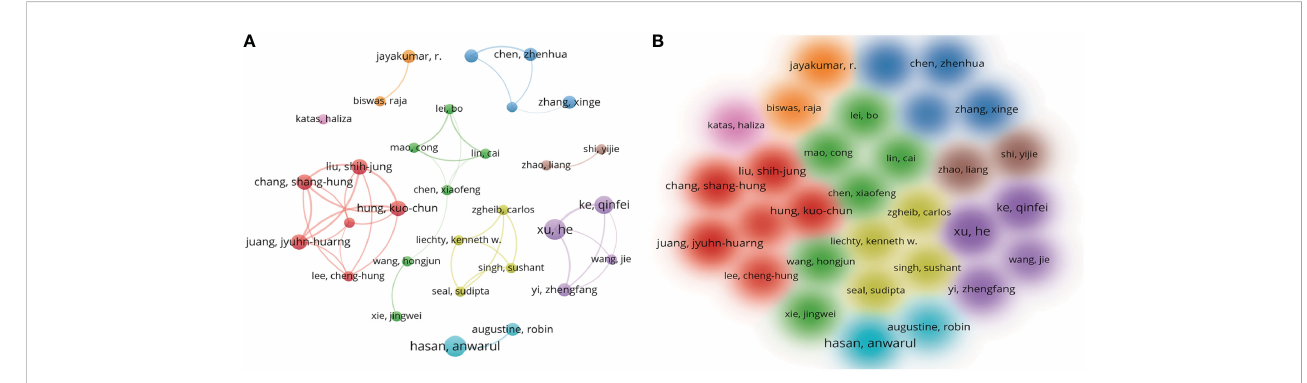
FIGURE 6 VOSviewer network map of authors (A) ; Density distribution map of authors (B)